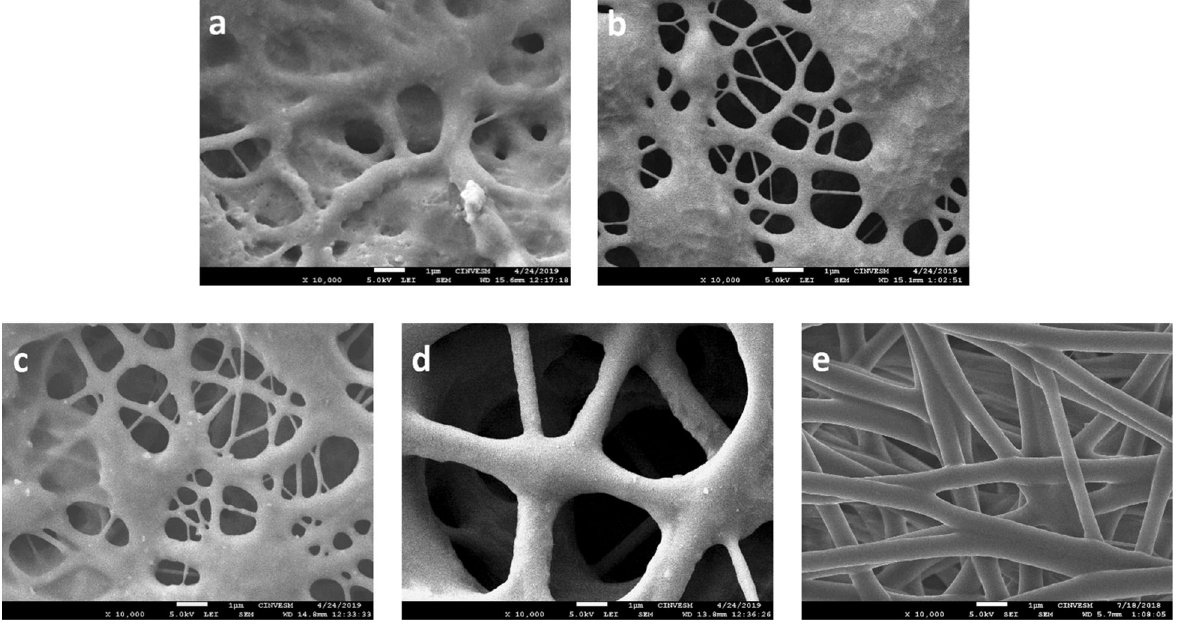
Fig. 3 SEM images of the electrospun PUUR membranes ( a ) 20% w/v, 18 kV, 1.2 ml h − 1 ; ( b ) 15% w/v, 20 kV, 0.8 ml h − 1 , ( c ) 15% w/v, 20 kV, 1.6 ml h − 1 , ( d ) the PUUE membrane, and ( e ) the Teco fl ex membrane